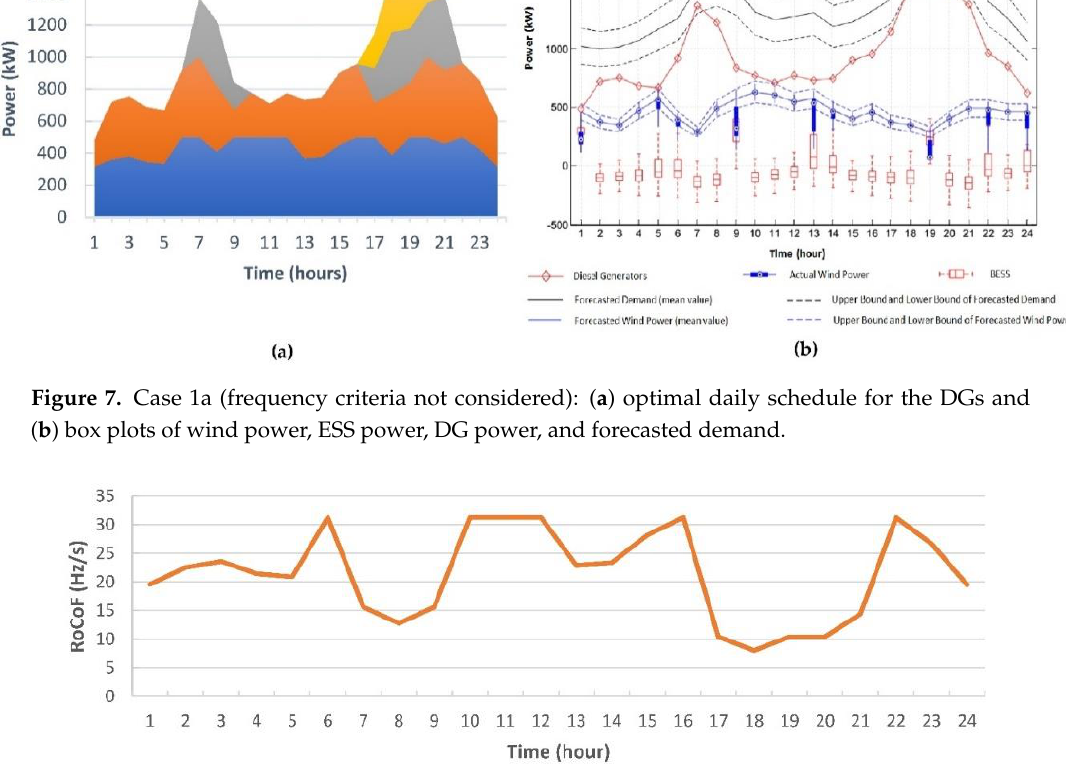
Figure 8. Rate-of-change-of-frequency (RoCoF) after a contingency event in Case 1a.